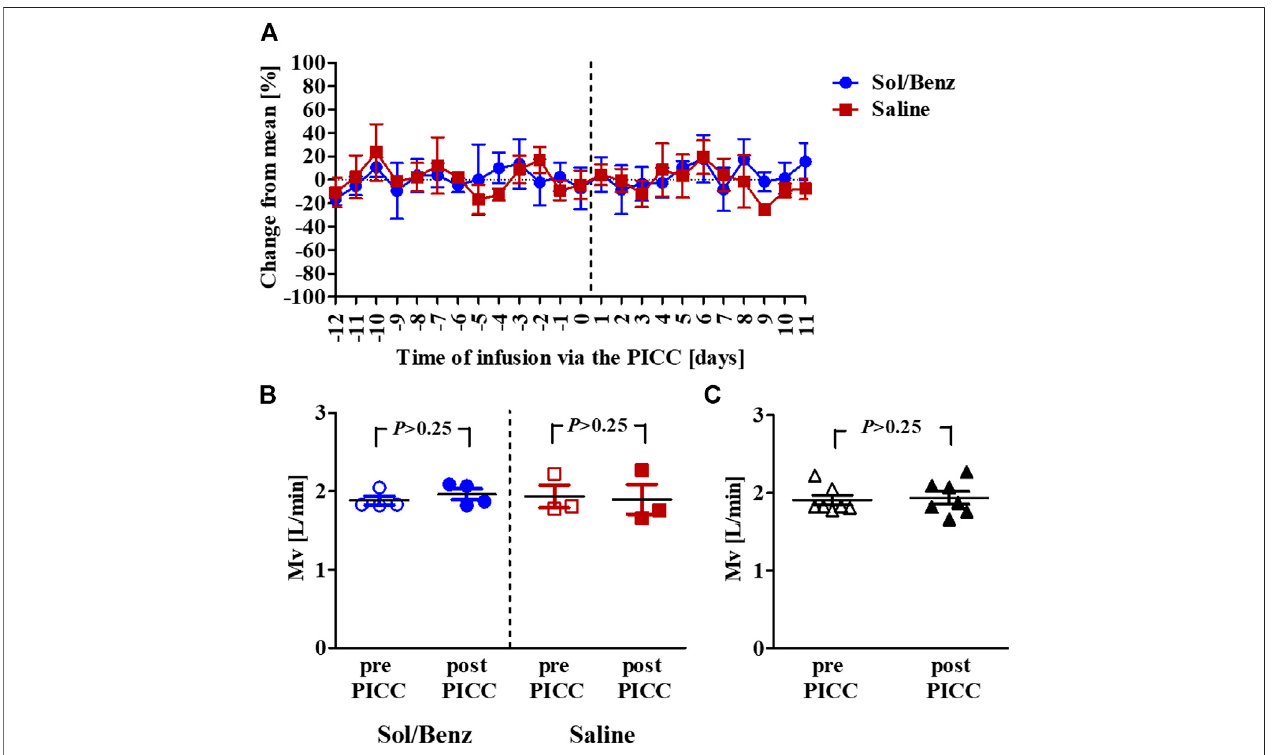
FIGURE 4 | Mean Mv values before and during the IV continuous infusion (A) Mean Mv values of rabbits infused with either saline (red squares) or solvent (blue circles). The vertical dashed line designates the PICC insertion time point (B) Mean Mv values before (empty signs) and after (whole signs) PICC insertion within each group.Thebluecirclesdesignatesolventinfusion,andtheredsquaresdesignatesalineinfusion (C) MeanMvvaluespre-(emptyrectangles)andpost-(wholerectangles) PICC insertion for all seven rabbits. p (cid:2) p value .